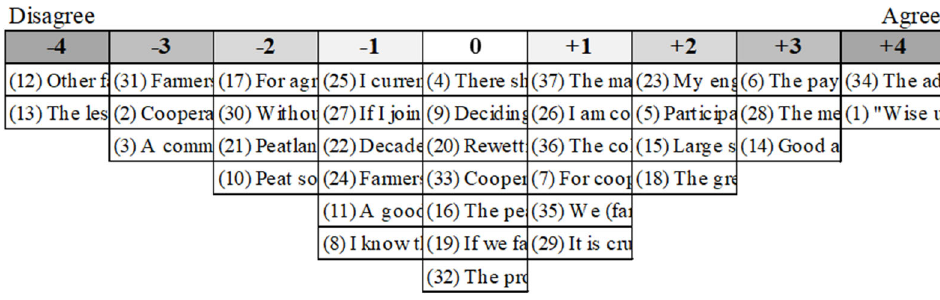
Figure A1. Example of a completed statement ranking (Q ‐ sort) by one of the participants.